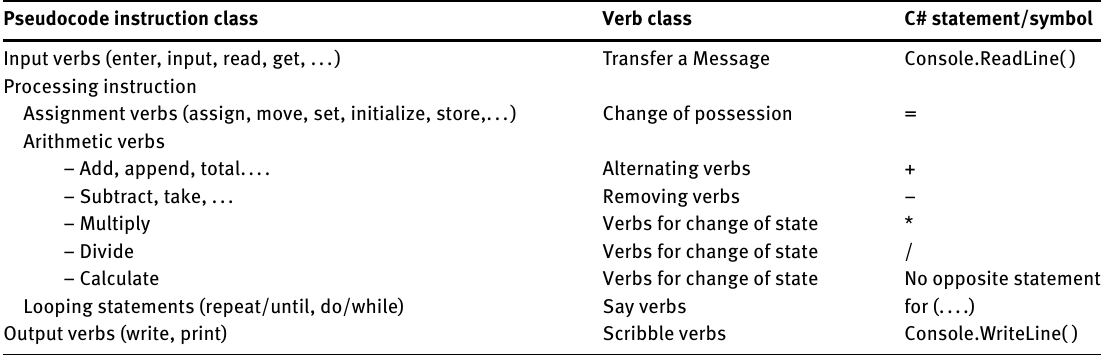
Table 5: Programming Statements Classes Versus Verb Classes.